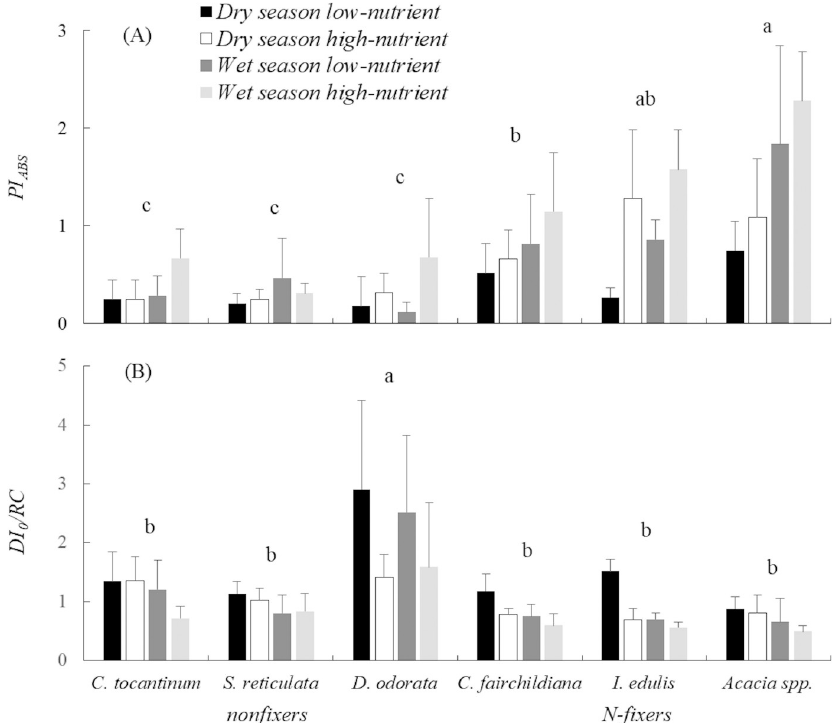
Fig 4. Performance index (A) and energy dissipation (B) of the six studied species under low vs. high water and nutrient availability (mean values ± SD). https://doi.org/10.1371/journal.pone.0243118.g004 the O-J and I-P rise. Unfertilized C . fairchildiana had a general reduction in the transient rise (Fig 5). I . edulis appears less sensitive to OJIP modifications. Fertilized D . odorata reduced the O-J-I rise with increased F and reduced maximum Chl a fluorescence ( F ), hereafter the 0 M maximum fluorescence (Fig 5). The enhanced photochemical efficiency of Acacia spp. was due